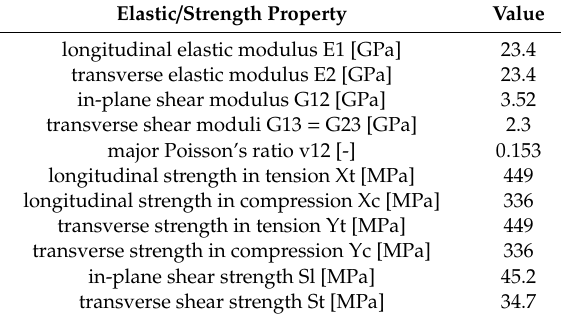
Table 1. Fiber reinforced plastic (FRP) lamina elastic and strength